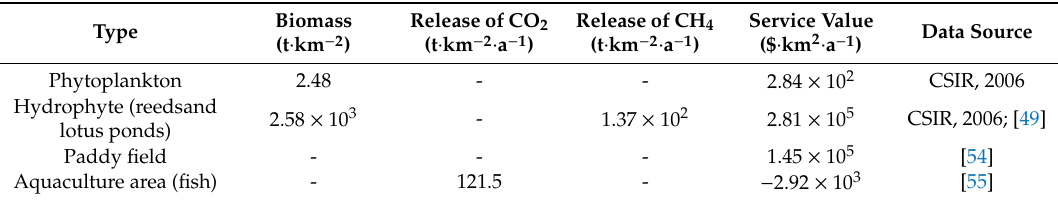
(reeds and lotus ponds), paddy field and aquaculture area (fish) in Nansi Lake wetland.